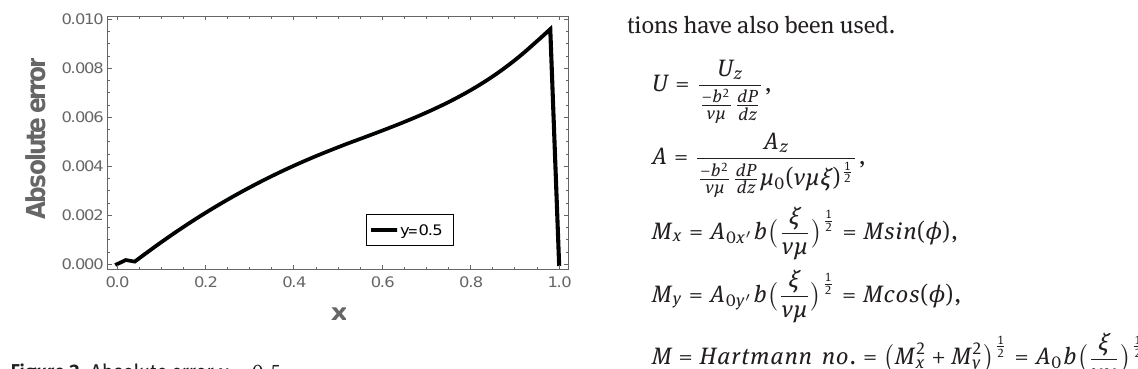
Figure 3: Absolute error y = 0.5